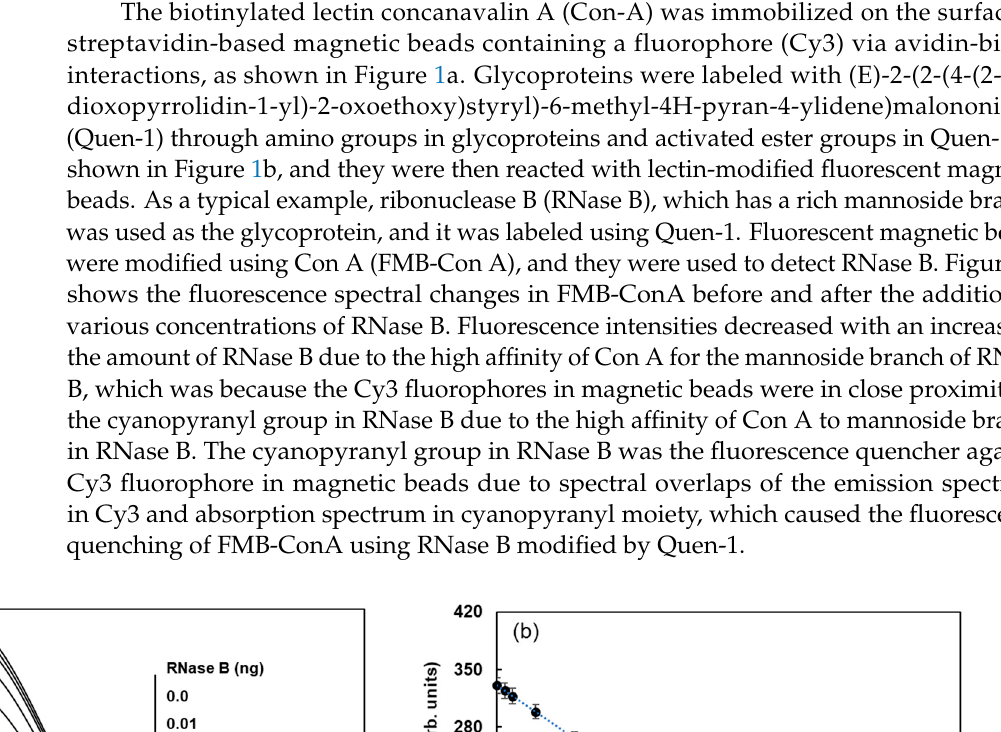
Figure 3. Fluorescence responses of FMB-Con A, FMB-WGA, and FMB-AAL after the addition of RNase-B modified using quenchers. [FMB-Con A] = [FMB-WGA] = [FMB-AAL] = 10 μ g/mL;